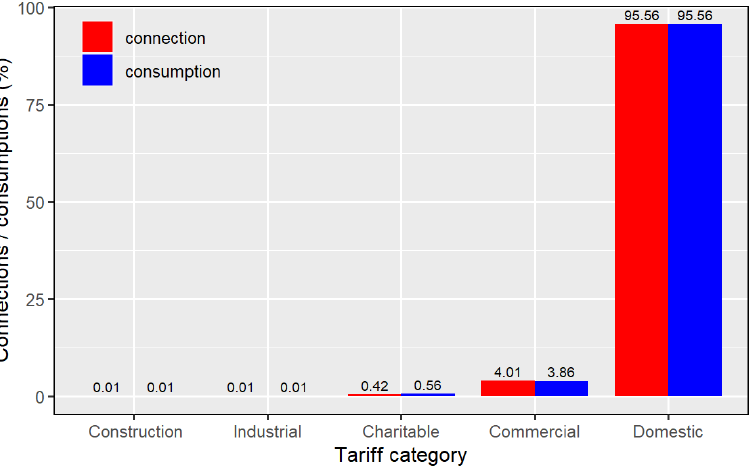
Figure 2. Percentages of connection numbers and water consumption for each tariff category in 2020.